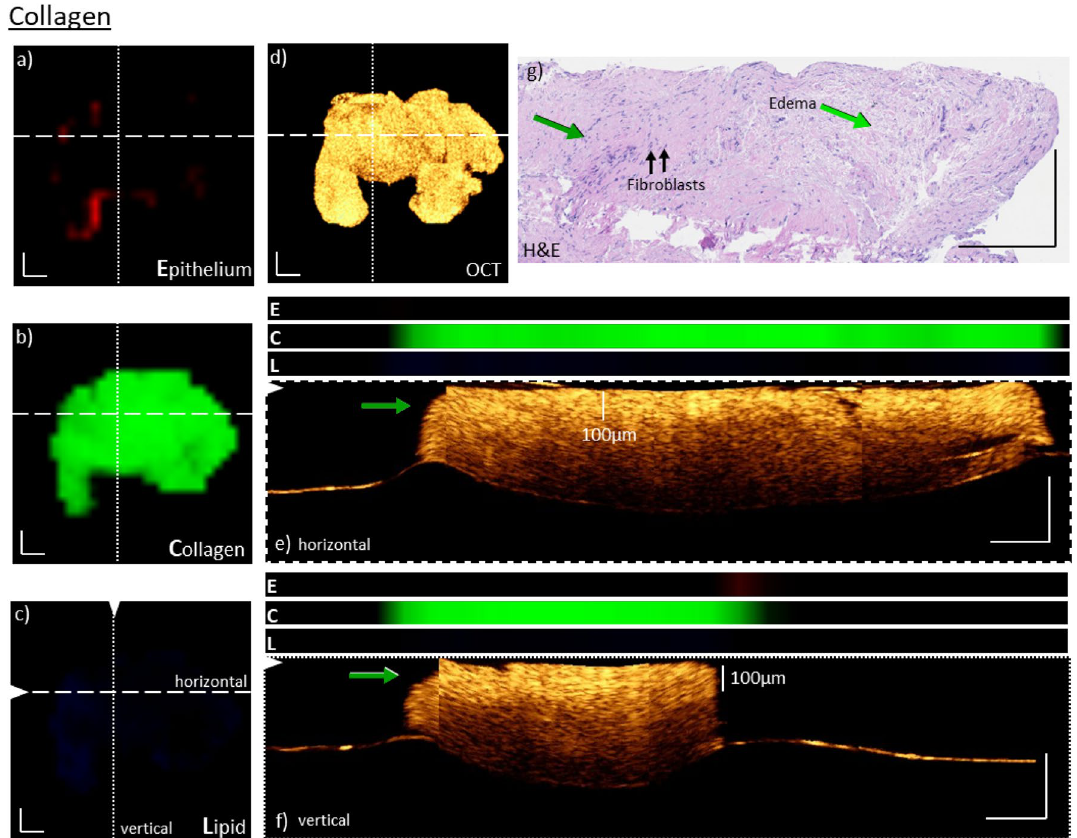
Figure 2. Co-registered morpho-molecular information of OCT and Raman images on a collagen rich bladder biopsy. Molecular Raman enface maps for epithelial ( a ), collagen ( b ) and lipid ( c ) content and enface OCT maximum intensity projection of ten slices from a depth of 120–150 µm ( d ). The Raman maps indicate a dominant and nearly homogenous collagen signal over the entire biopsy ( b ), whereas the lipid content and epithelial signal is not very pronounced ( a , c ). The molecular information corresponds well to the very bright OCT signal. Maximum intensity projections of 10 cross-sectional OCT B-scans are indicated for positions in the biopsy by dashed and dotted lines in the enface image ( e , f ), respectively. The co-registered molecular information for the three components (E: Epithelium, C: Collagen, L: Lipid) are plotted above. It can be seen that neither B-scans in ( e ) nor ( f ) do exhibit an epithelium layer, however, show features with a very bright appearance. For comparison, an H&E image of the respective biopsy is displayed in ( g ). In the H&E slice ( g ), only lamina propria tissue is present, green arrows. The whole section does not exhibit any epithelial cell layer. A region of edema within the lamina propria is identified. Further, two representative fibroblasts, building up the extracellular matrix constructed mainly of collagen fibers are pinpointed. Scale bars: 250